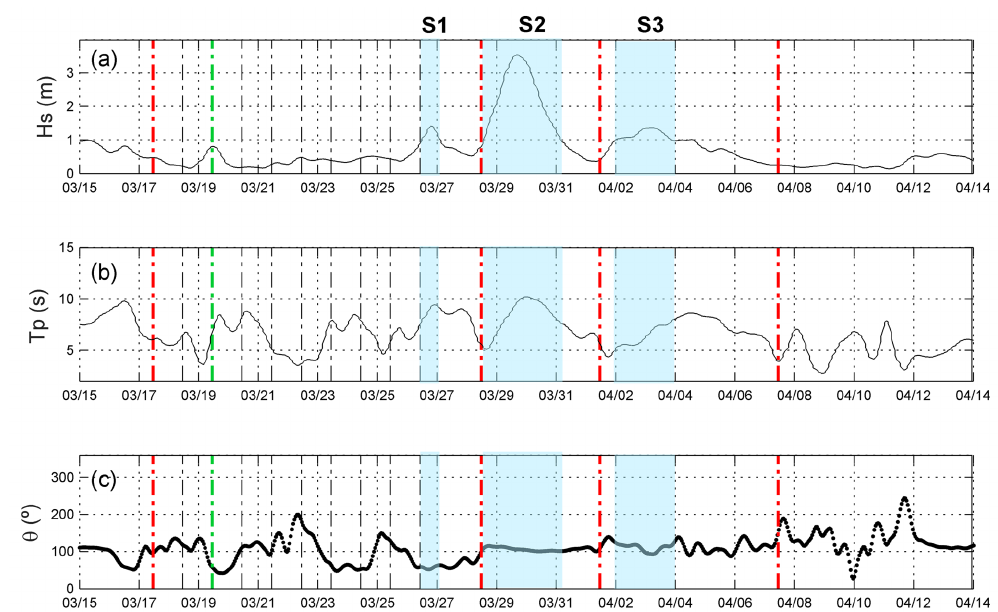
Figure 4. (a) H s (m) at 25m in Cala Millor between 15 March and 14 April 2014. (b) T p (s). (c) Wave direction. The blue shading shows the period corresponding to the storms. Vertical red dotted lines indicate the initial bathymetry obtained while dashed dotted lines indicate the dates when cross-shore profiles were measured. Vertical green dotted lines state the day when the model was validated using the corre- sponding shore profiles. Vertical red lines show the date when bathymetry inferred from XBeach was used for comparison among